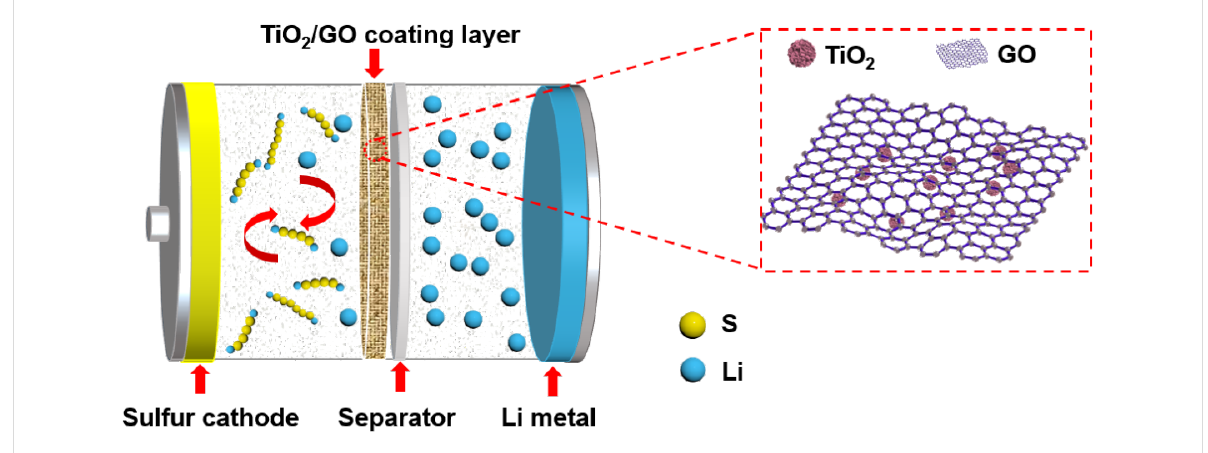
Figure 1: Schematic illustration of a Li/S battery with a TiO 2 /GO-coated functional separator.